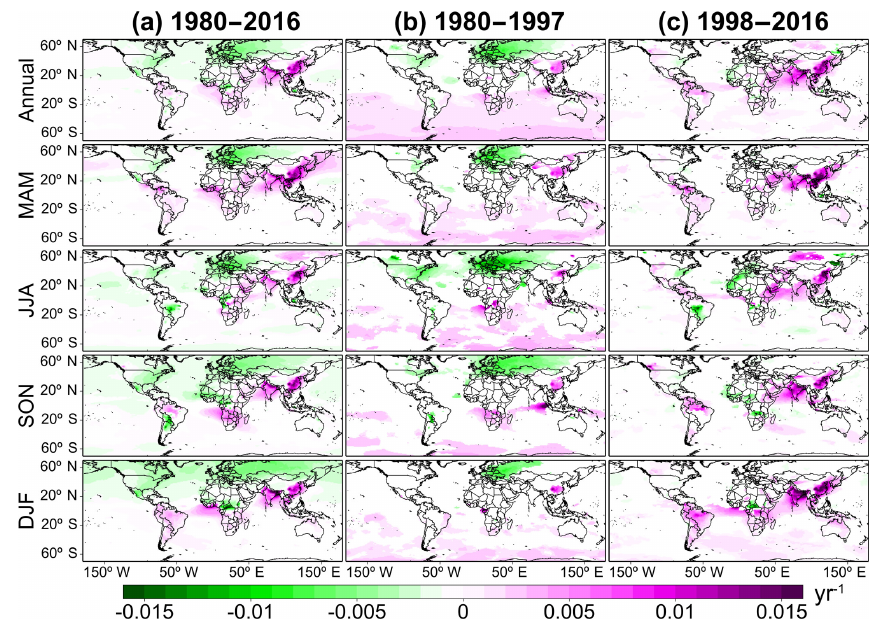
Figure 6. Spatial distributions of the linear trends in annual and seasonal MERRA-2 AOD calculated from the time series value of the deseasonalized monthly anomaly during (a) 1980–2016, (b) 1980–1997 and (c) 1998–2016. Only trend values with statistical significance at the 95% confidence level are